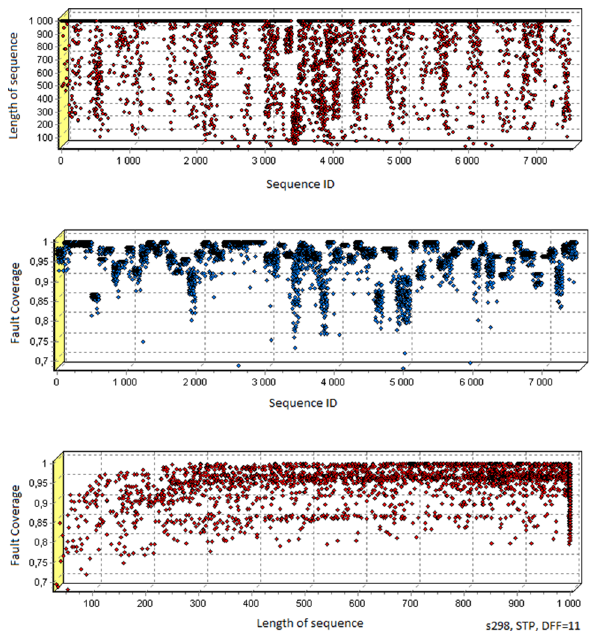
Fig. 32 STP for s298 with use of 11 internal flip-flops the (MM) elements, converts the sequential circuit